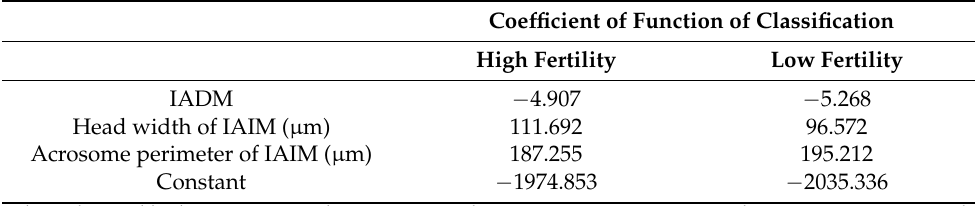
Table 2. Discriminant classification matrix showing Fisher’s linear discriminant functions. Coefficient of Function of Classification